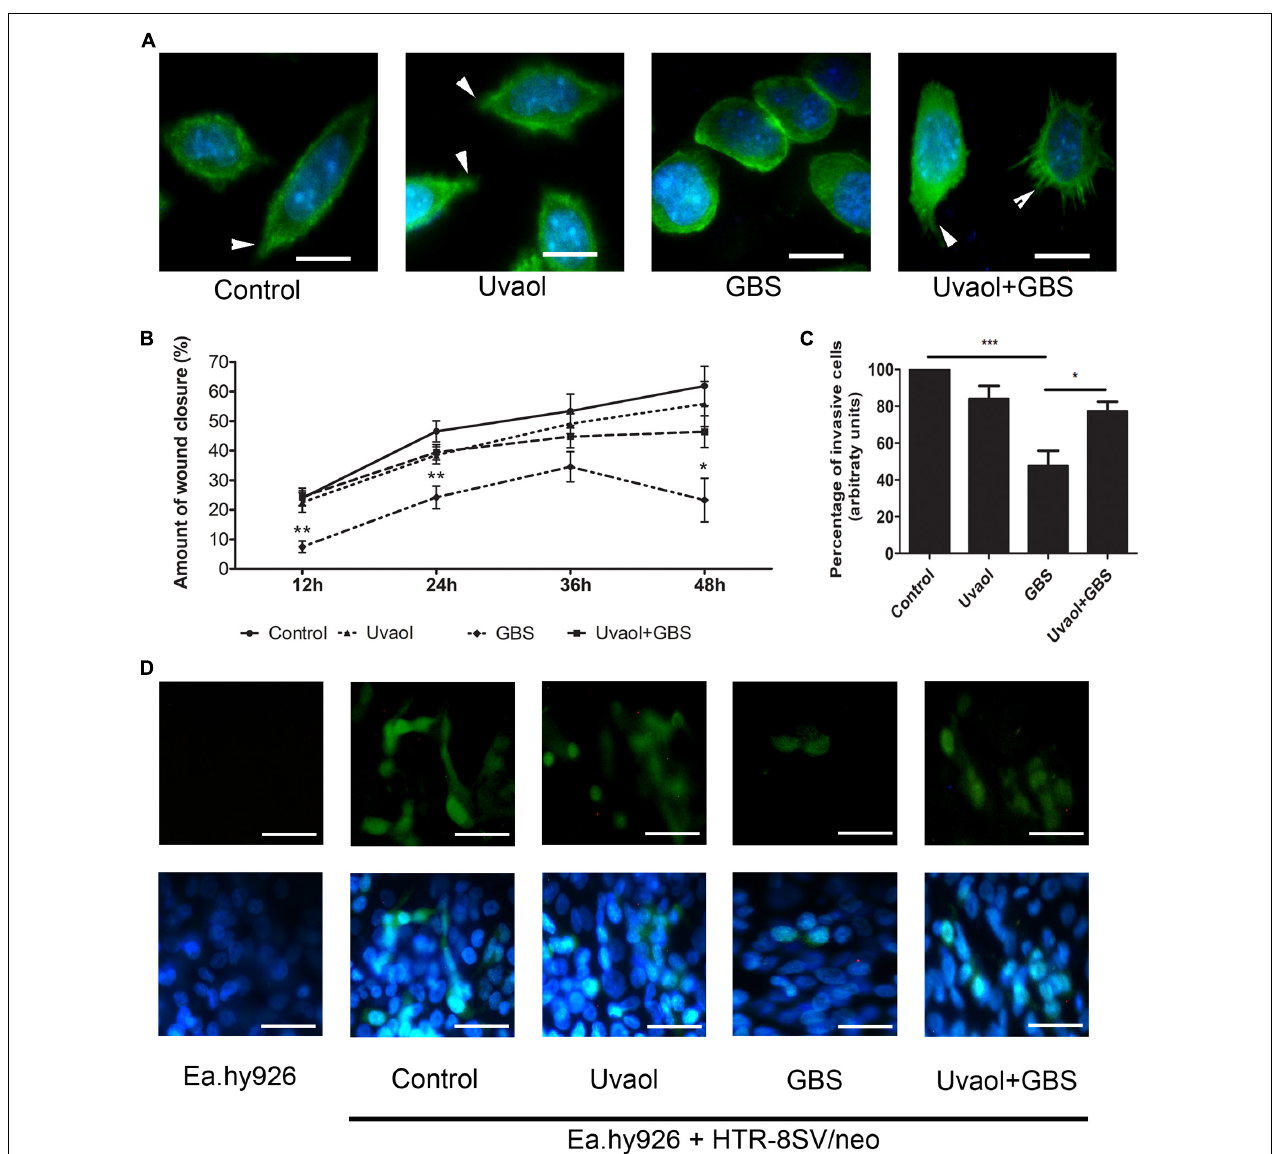
FIGURE 5 | GBS reduces trophoblast cell motility, and uvaol prevents reduction. (A) Phalloidin (green) and nuclei staining (DAP-I) of trophoblast cells from control, 10- µ M uvaol, GBS at 1 × 10 6 CFU, or both (uvaol + GBS). Filopodia are identified by white arrowheads. 1,000 × magnification. Scale bars represent 50 µ m. (B) Percentage of in vitro wound closure per time point analyzed (12, 24, 36, and 48 h). A bar graph represents mean values ± S.E.M.; *, p < 0.05; **; p < 0.01. Two-way ANOVA with Bonferroni post hoc test. (C) Percentage of invasive trophoblast cells through 3D vascular invasion assay. A bar graph represents mean values ± S.E.M.; *, p < 0.05; ***; p < 0.001. One-way ANOVA with Tukey post hoc test. (D) Representative images from the 3D coculture vascular invasion assay with CFSE-stained trophoblast cells and nuclei stained with DAP-I, where: (first column) Ea.hy926 endothelial cells, (second column) control (endothelial + trophoblast cells), (third column) with uvaol, (fourth column) with GBS, (fifth column) with uvaol and GBS. 400 × magnification. Scale bars represent 200 µ m. All experiments were n = 3 in